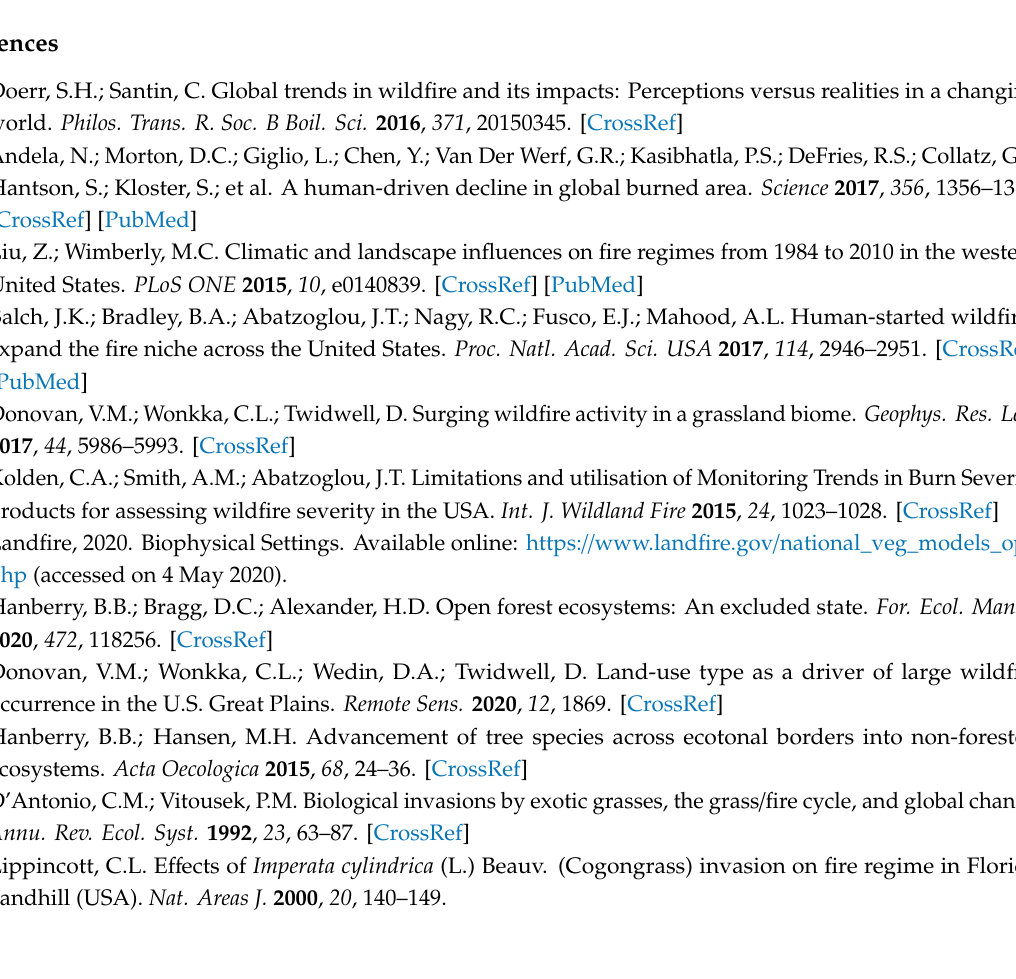
Figure S1: Partial dependence plots for c5.0, random forests, and extreme gradient boosting models of all fires in the conterminous United States, Figure S2: Partial dependence plots for c5.0, random forests, and extreme gradient boosting models of the eastern United States, Figure S3: Partial dependence plots for c5.0, random forests, and extreme gradient boosting models of the central United States, and Figure S4: Partial dependence plots for c5.0, random forests, and extreme gradient boosting models of the western United